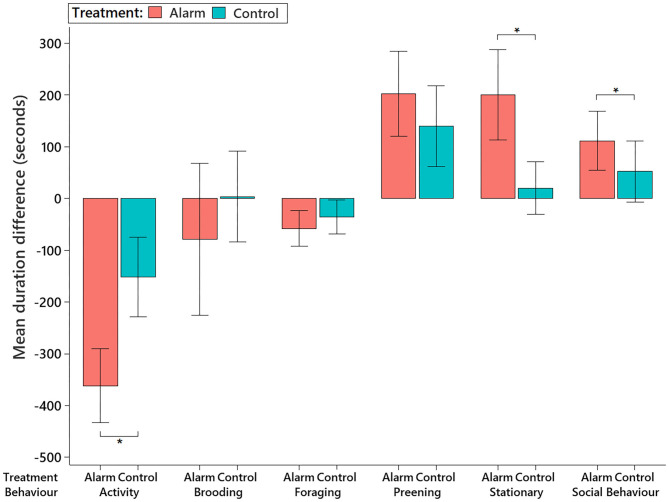
Mean (±95% CI) differences in time the birds spent (in seconds) performing different behaviors on the alarm and control days. Differences were calculated by subtracting the total duration of each behavior in the 15 min immediately before the stimulus interval from the duration observed on the 15 min subsequently after the stimulus. Behaviors marked with an asterisk *showed a significant difference (P < 0.05) on the behavioral pattern observed after the stimulus between the test days.